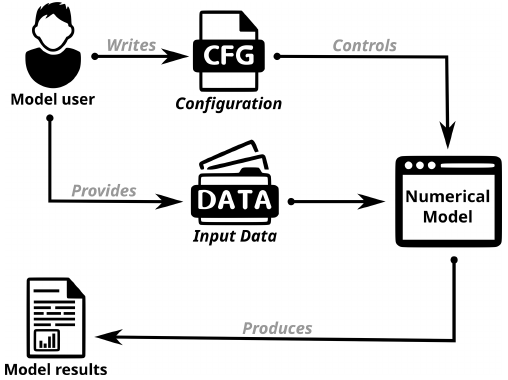
Figure 1. Numerical models from the user point of